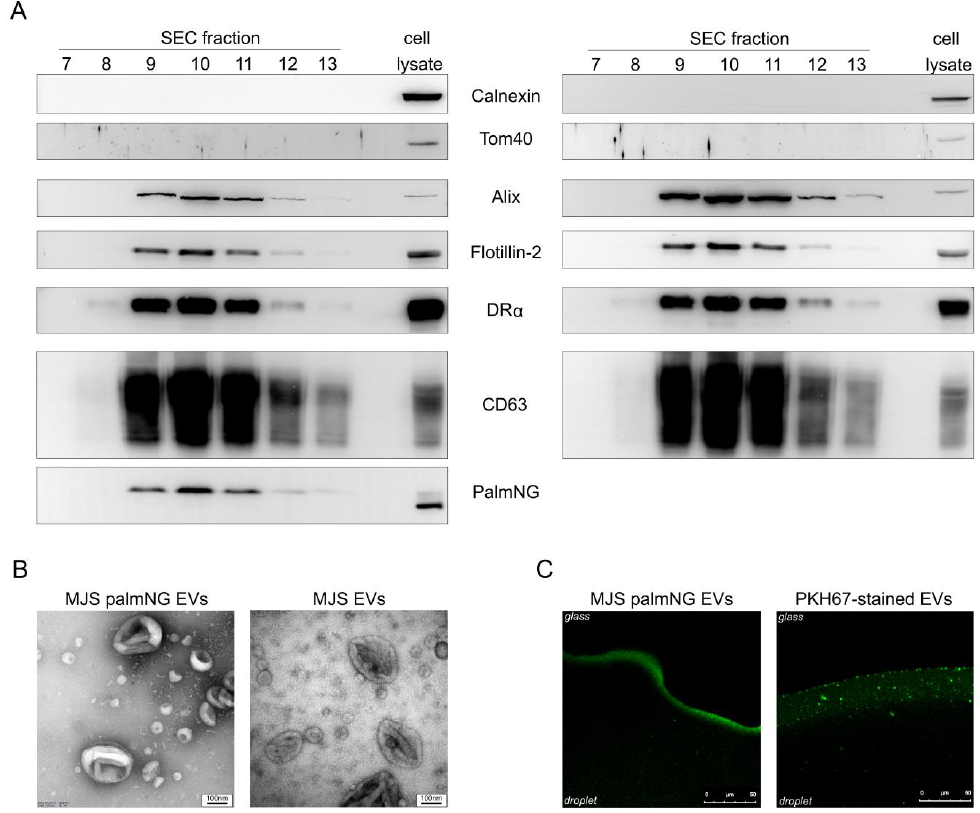
Figure 2. Characterization of size exclusion chromatography (SEC)-purified EVs. EVs from MJSpalmNG (left panels) and MJS (right panels) were isolated by SEC. ( A ) Selected fractions (20 µ L) were analyzed by SDS-PAGE and immunoblotting for the presence of EVs markers with the use of anti-Alix, anti-flotillin-2, anti-DR α , anti-CD63 antibodies, and for the presence of cellular markers with the use of anti-calnexin and anti-Tom40 antibodies. The presence of palmNG in the EVs-enriched fractions was confirmed with anti-NeonGreen antibodies. A cell lysate from the EVs donor cell line was used as a control. ( B ) Representative transmission electron microscopy images of EVs from pooled EVs-containing fractions (F9-F11); scale bar 100 nm. ( C ) Fluorescent EVs in solution (a droplet on a coverglass). The images of the MJSpalmNG EVs or PKH67-stained MJS EVs were captured using a confocal laser scanning microscope.